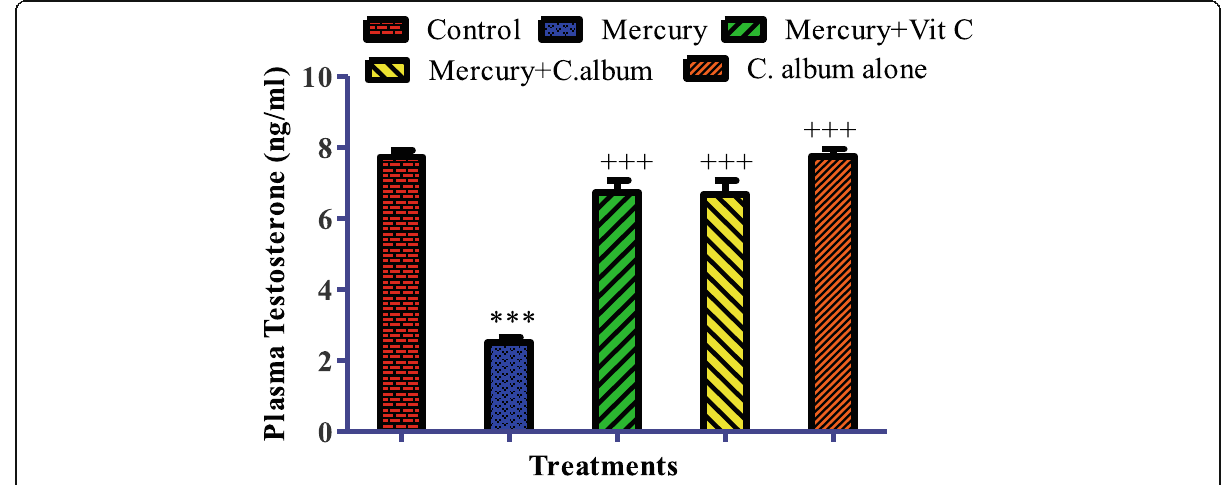
Fig. 1 Effect of different treatments on plasma testosterone concentration